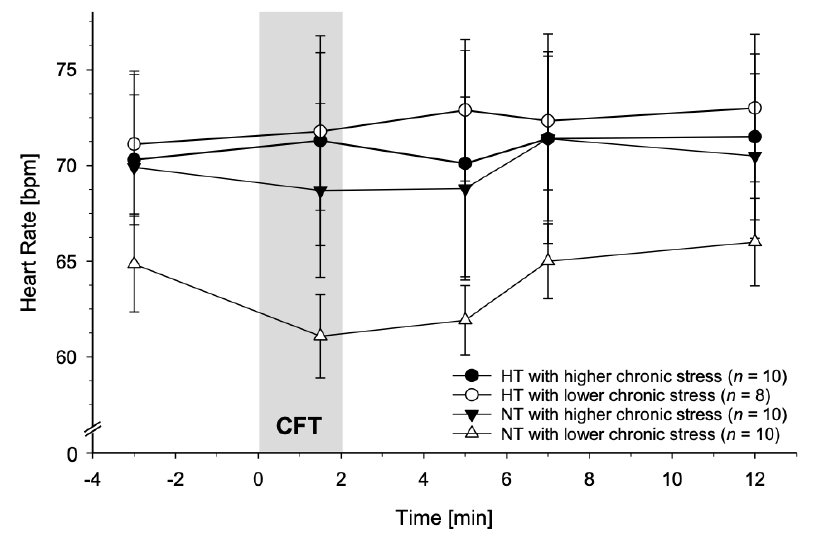
Figure 4. Heart rate (HR) reactivity to Cold Face Test (CFT; grey bar) in hypertensive participants and normotensive controls with higher and lower chronic stress (mean ± SEM). A general linear model revealed that chronic stress moderates HR reactivity to CFT (three-way interaction TICS-CSSS-by-group-by-time: p < 0.045) with chronically stressed normotensives resembling the HR reactivity patterns of hypertensives.